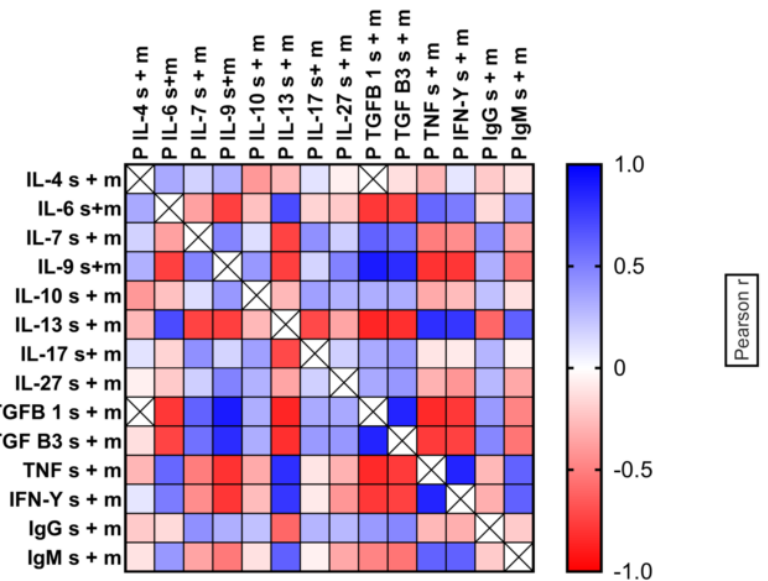
Figure 5. Heat map correlations calculated by Pearson protocols for all cytokines in combined mild and severe malaria patients.